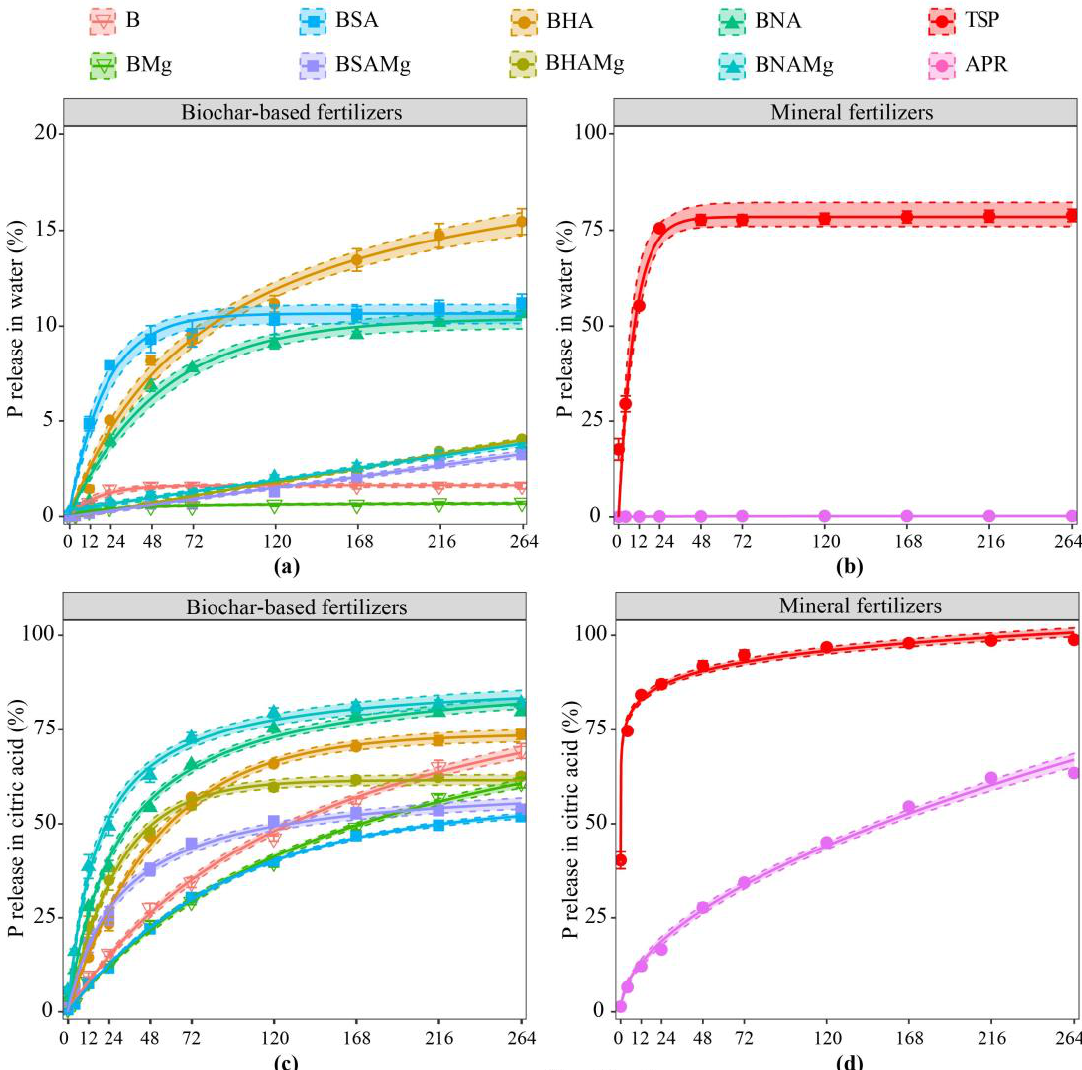
Figure 4. The kinetics of P release in water ( a, b ) and citric acid at 2% ( c, d ) as related to the total P content of biochar based-fertilizers (BBFs) and mineral fertilizers (TSP: triple superphosphate; APR: Araxá phosphate rock). More details of the BBFs acronyms and synthesis routes are shown in Table 1.